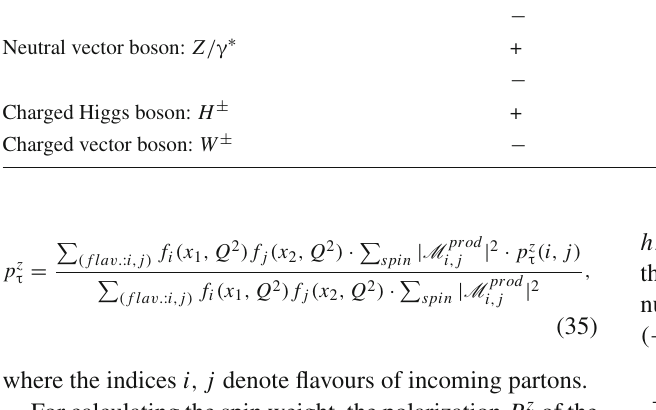
Table 3 Probability for the helicities of the of τ leptons from different origins [36] Origin Hel. τ 1 Hel. τ 2 Prob.